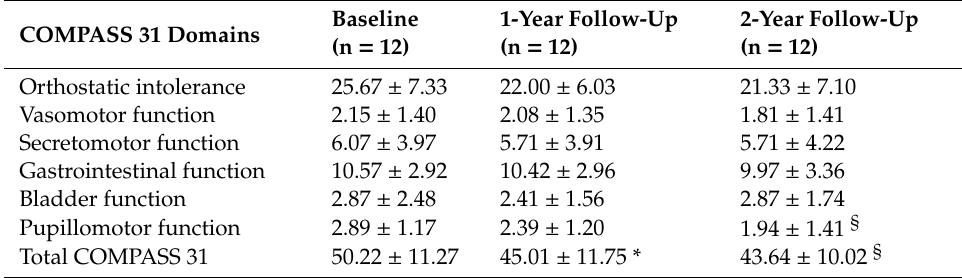
Pupillomotor function